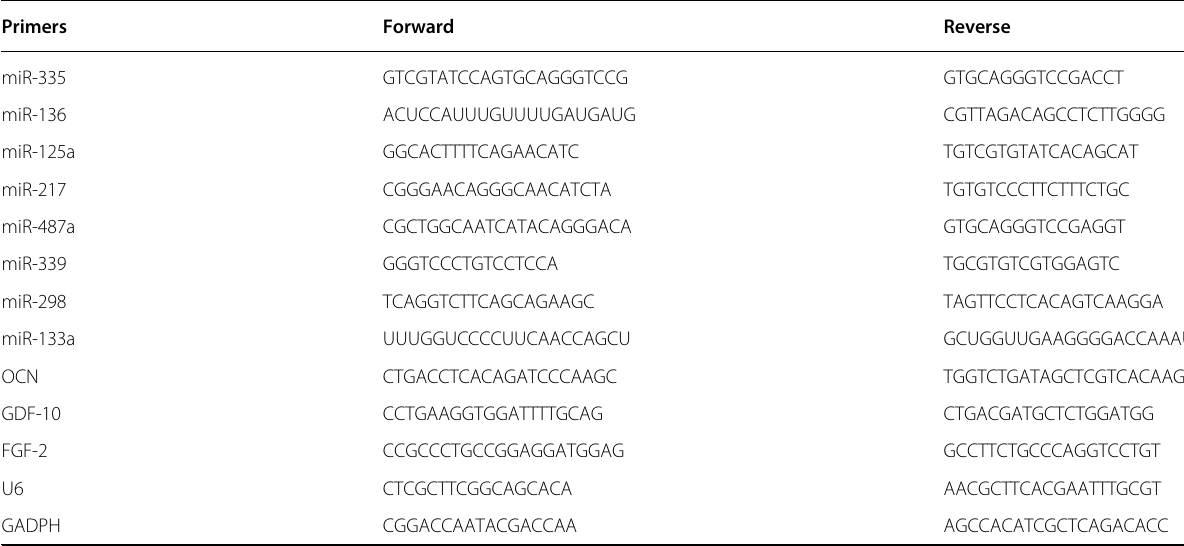
Table 1 Primer sequences of RT-qPCR.